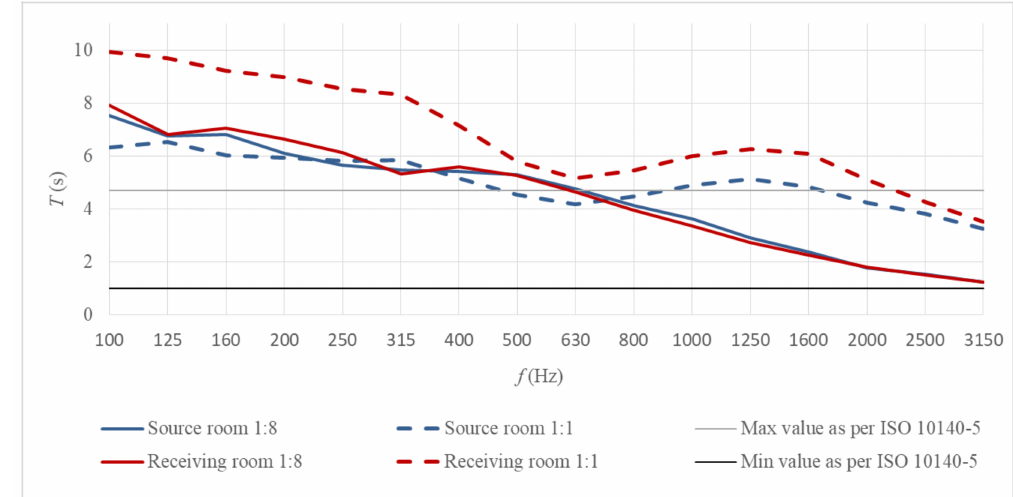
Figure 5. Reverberation times in the source and receiving rooms of the full-scale measurement stand and its counterpart at the 1:8 scale; the results from the scaled rooms were scaled to actual measurement